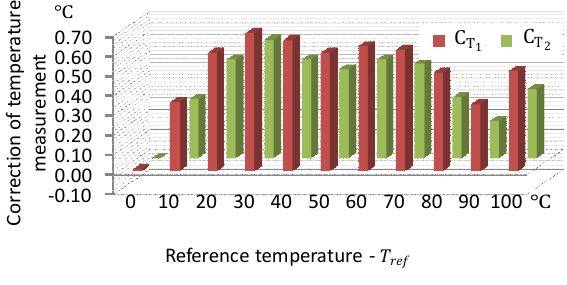
Fig. 7 . Correction of temperature measurement C Ti as a function of the reference temperature - T